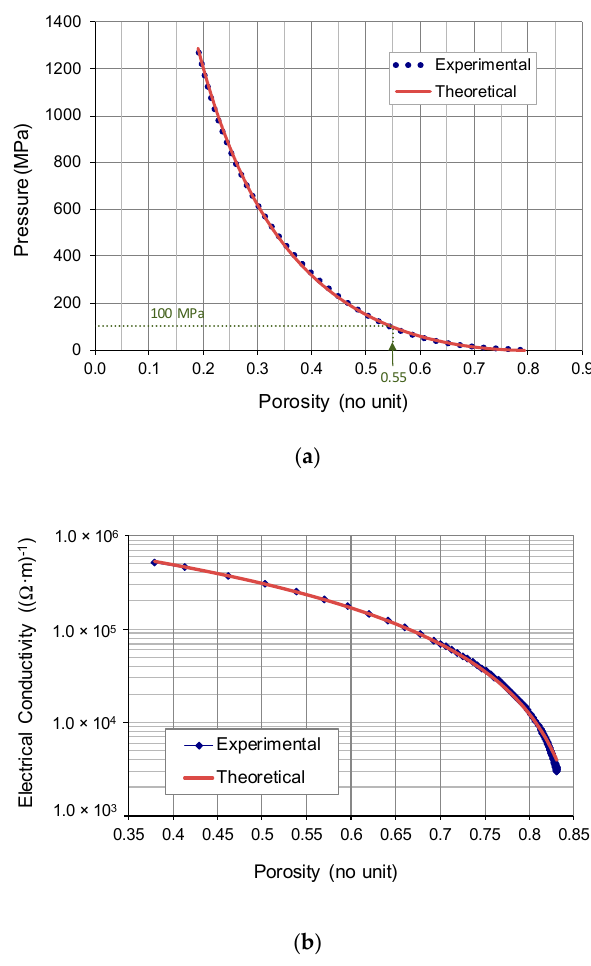
Figure 6. ( a ) Compressibility curve, and ( b ) Electrical conductivity vs. porosity, for a Ni Type 255 powder mass.